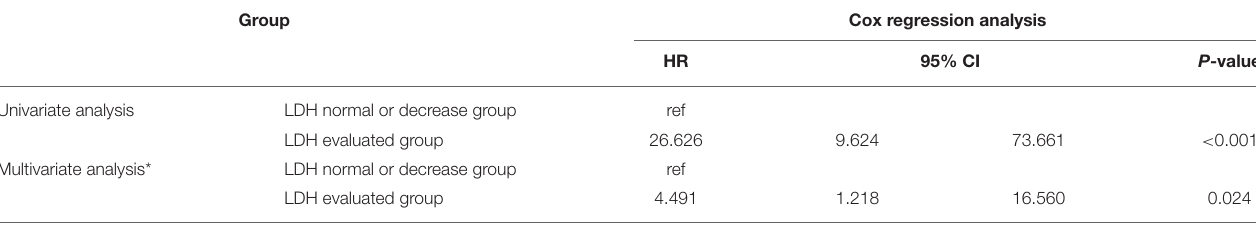
TABLE 3 | Univariate and multivariate Cox regression analysis for the survival of patients in different LDH level.